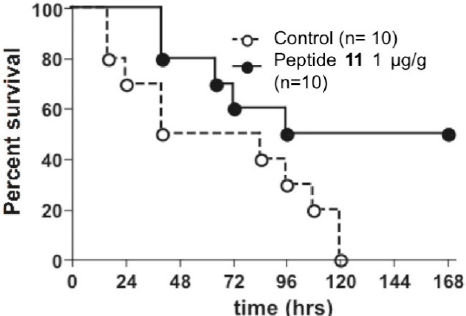
Figure 9. Survival after acute cecal ligature and puncture (CLP) in PBS-injected mice (open circle; n = 10) and peptide 11-injected mice (closed circle; n = 10). Kaplan–Meier curves and log-rank test were used to analyze the mortality rate; P =